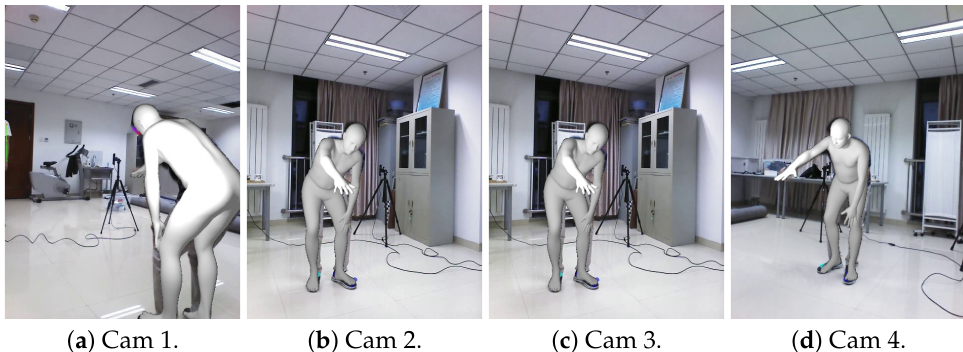
Figure 8. The SMPL parameters’ fitting results with projected vertex on the original images.